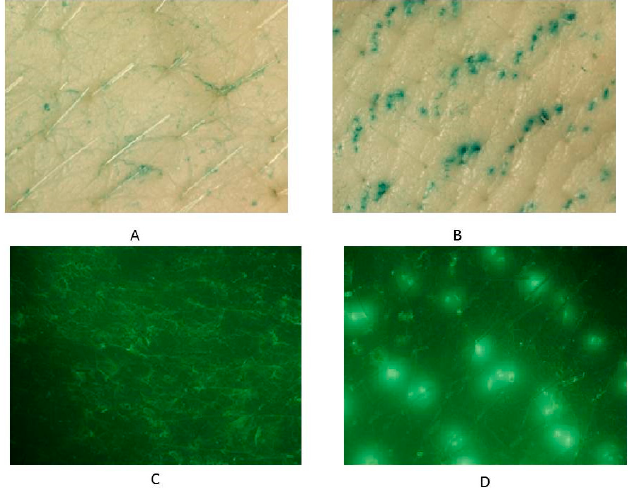
Figure 2. Microchannel visualization using Fast Green FCF on ( A ) untreated skin and ( B ) microneedle-treated skin; Alexa Fluor ® 488 on ( C ) untreated skin and ( D ) microneedle-treated skin using 7.5 × magnification.